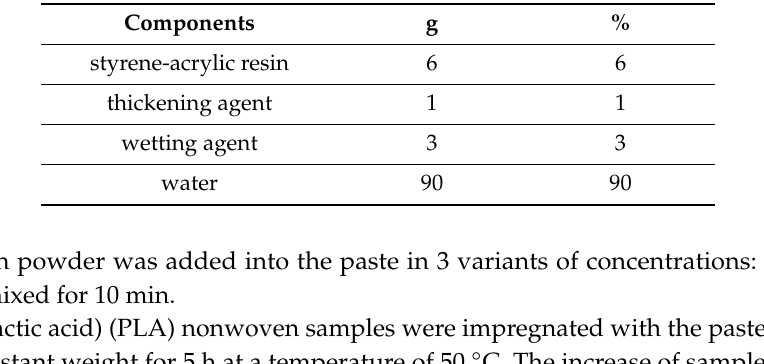
Table 3. Component composition of used pastes